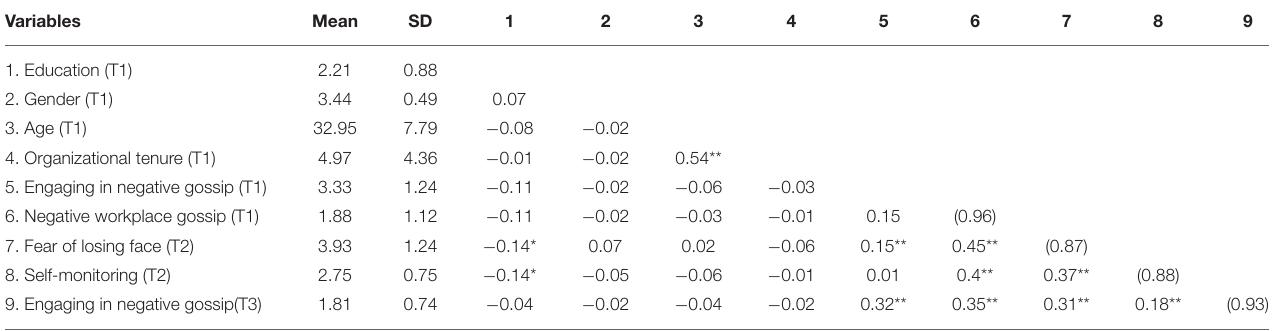
TABLE 1 | Descriptive statistics, reliability estimates, and study variable intercorrelations. Variables